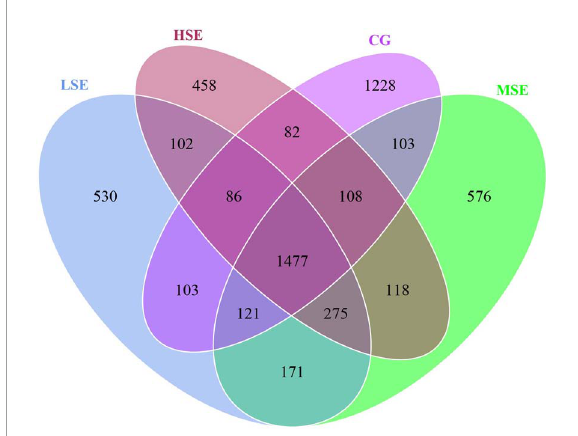
FIGURE1 The Venn diagram of the shared and unique OTUs throughout the four different SeHLan added groups. CG, control group; LSE, low Se group; MSE, medium Se group; HSE, high Se